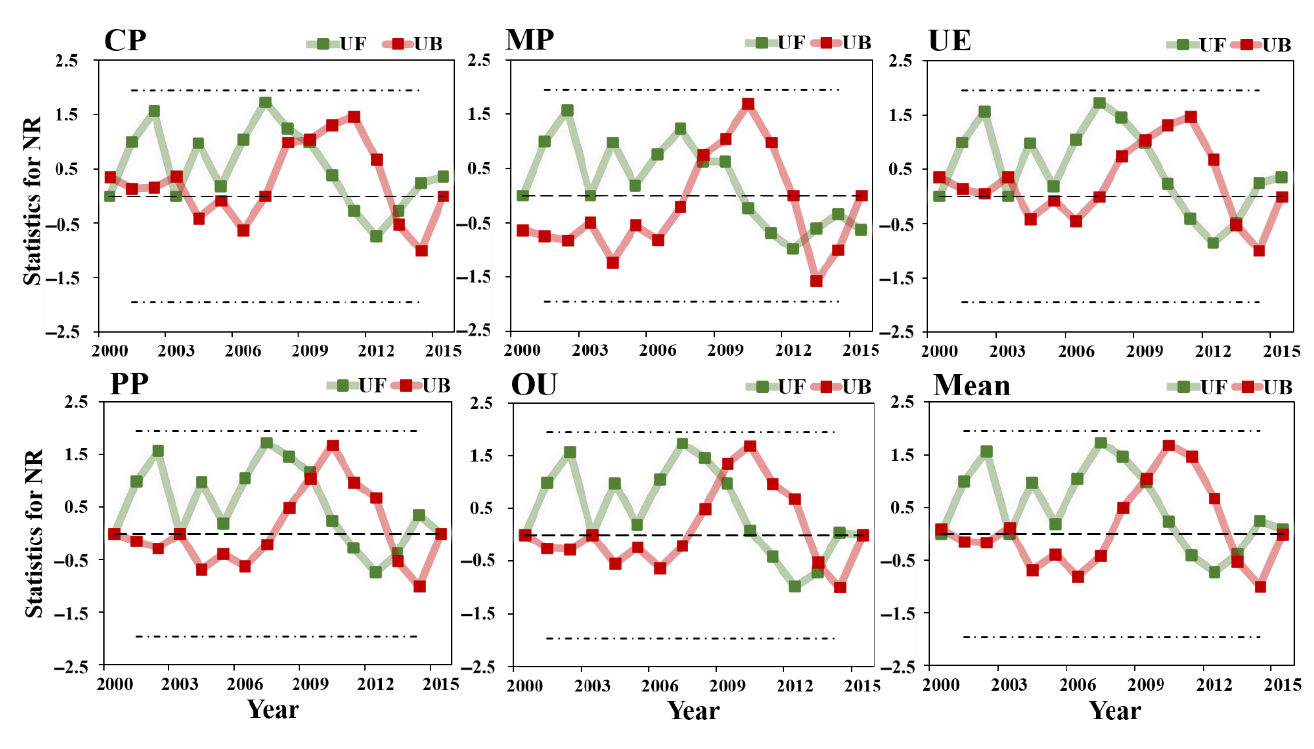
Figure 8. Mann – Kendall test of net radiation (NR) for different land use types in the Huang-Huai- River Basin from 2000 to 2015. Hai River Basin from 2000 to 2015.